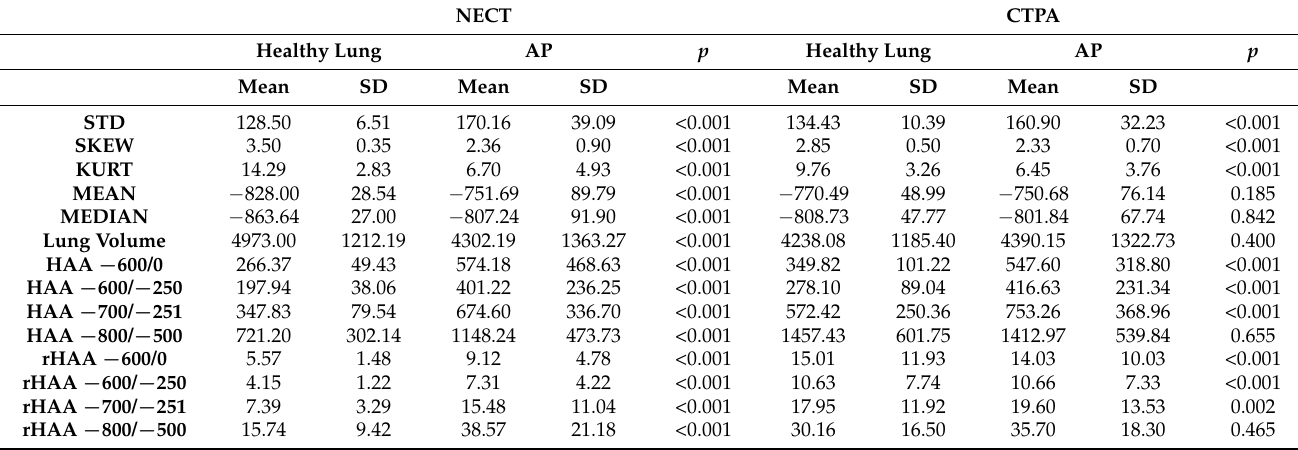
Table 2. Results of histogram analysis and HU threshold-derived